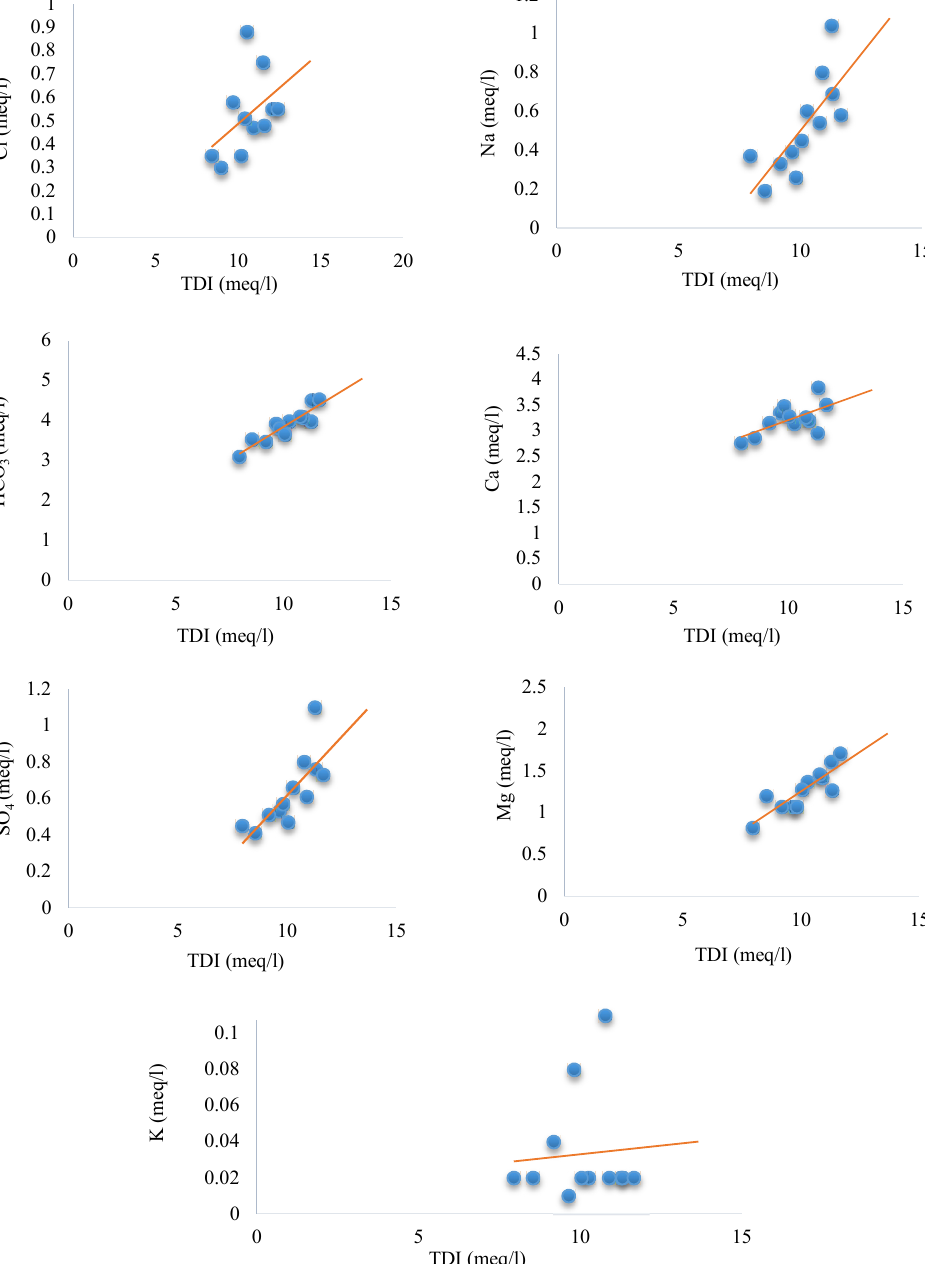
Fig. 4. Composite diagrams of ions versus TDI in the study